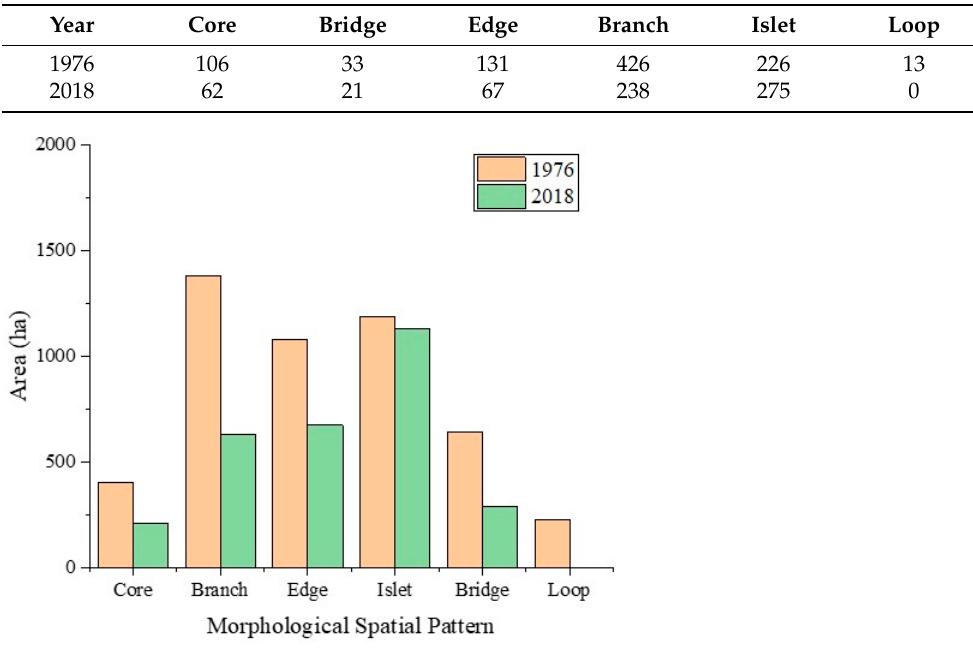
Figure 10. The areas of different morphological spatial pattern classes of historical forests in 1976 and 2018.